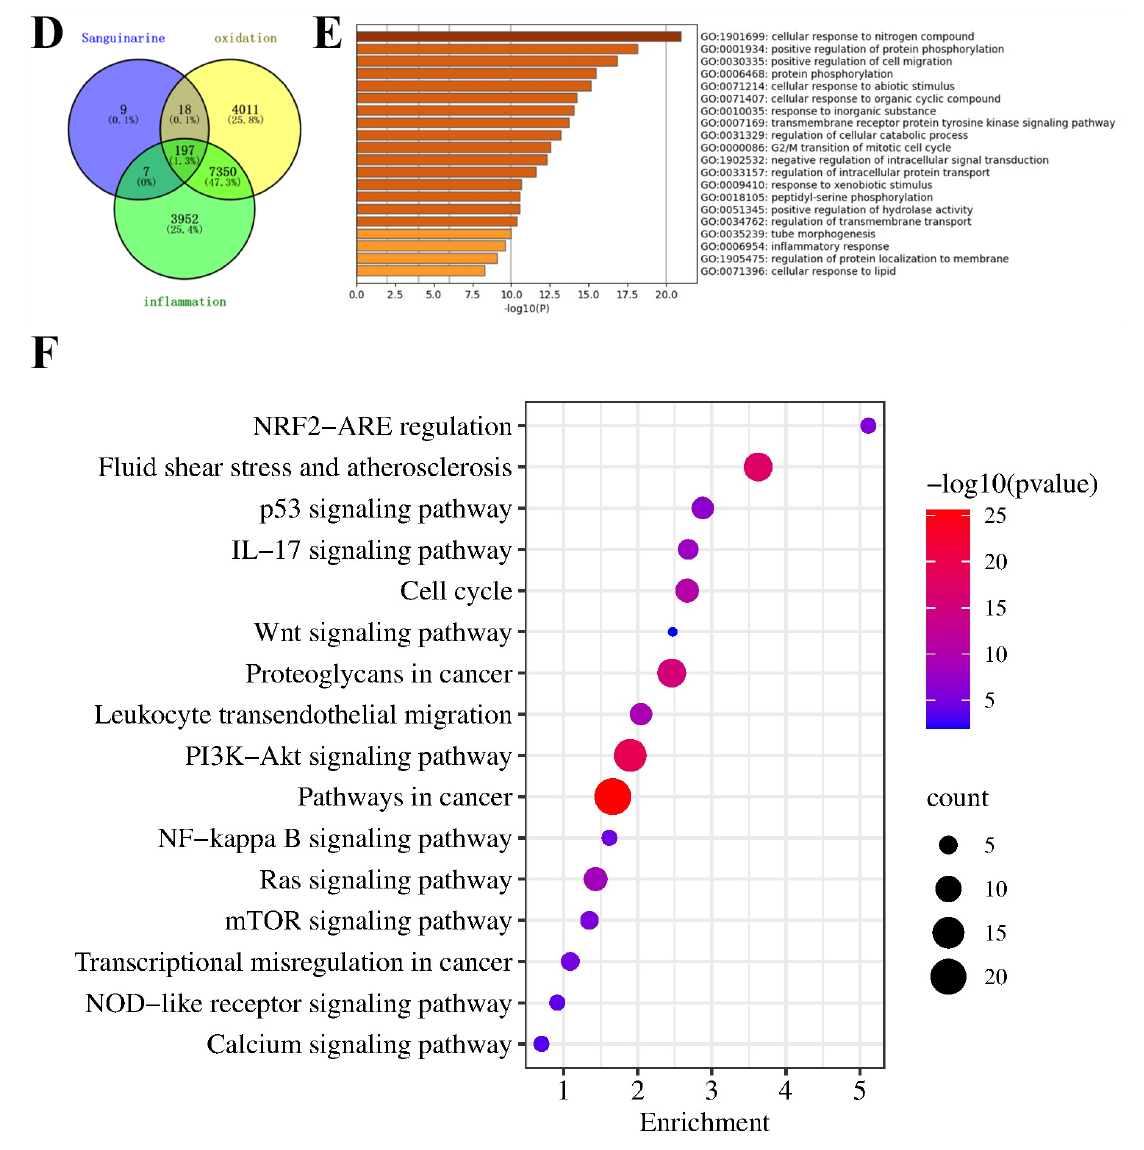
Figure 2. Network pharmacological analysis of SG. ( A ) Three-dimensional structure formula of SG. ( B ) The target classes of SG. ( C ) The potential targets of SG were predicted using the SwissTarget web- site. ( D ) The common target genes in “SG”, “inflammation”, and “oxidation”. ( E , F ) GO annotation and KEGG were used to analyze these target